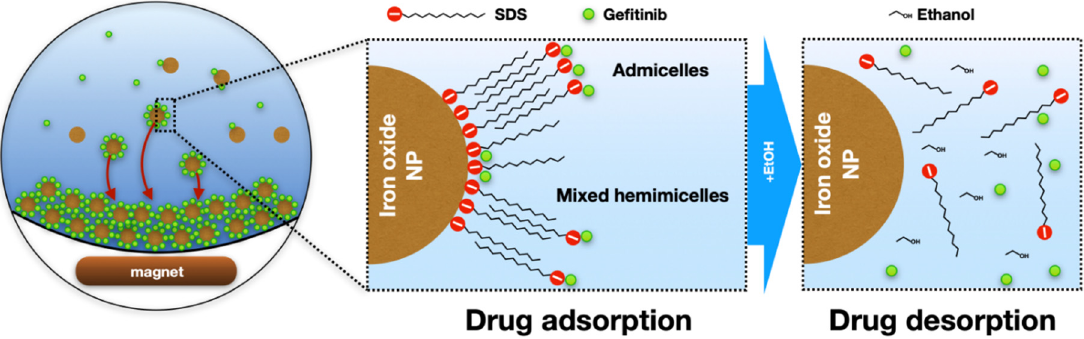
Figure 3. X-ray di ff raction (XRD) pattern of the prepared iron oxide MNPs. Figure 3. X-ray diffraction (XRD) pattern of the prepared iron oxide MNPs.